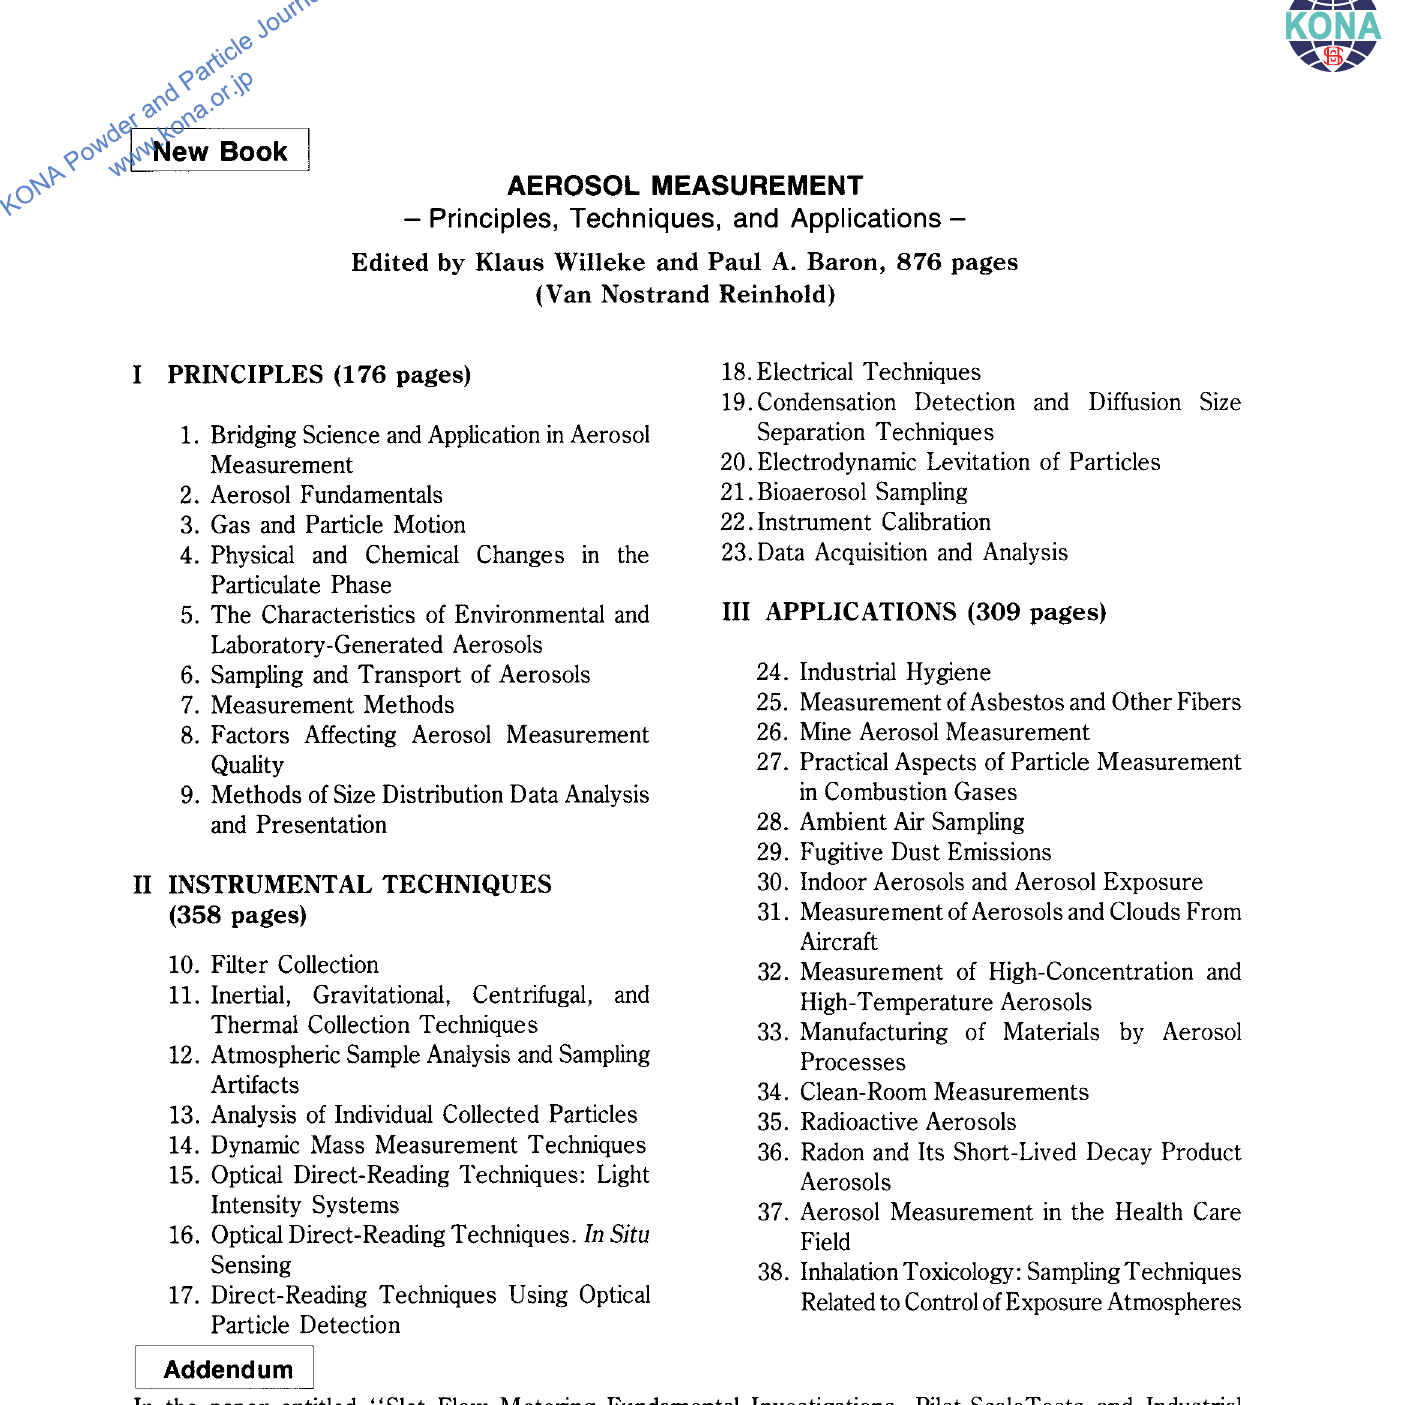
Table 1. Experimental results of Davies and Foye (1991) 1, Davies eta! (1992)2 and Harris eta!. (1992)